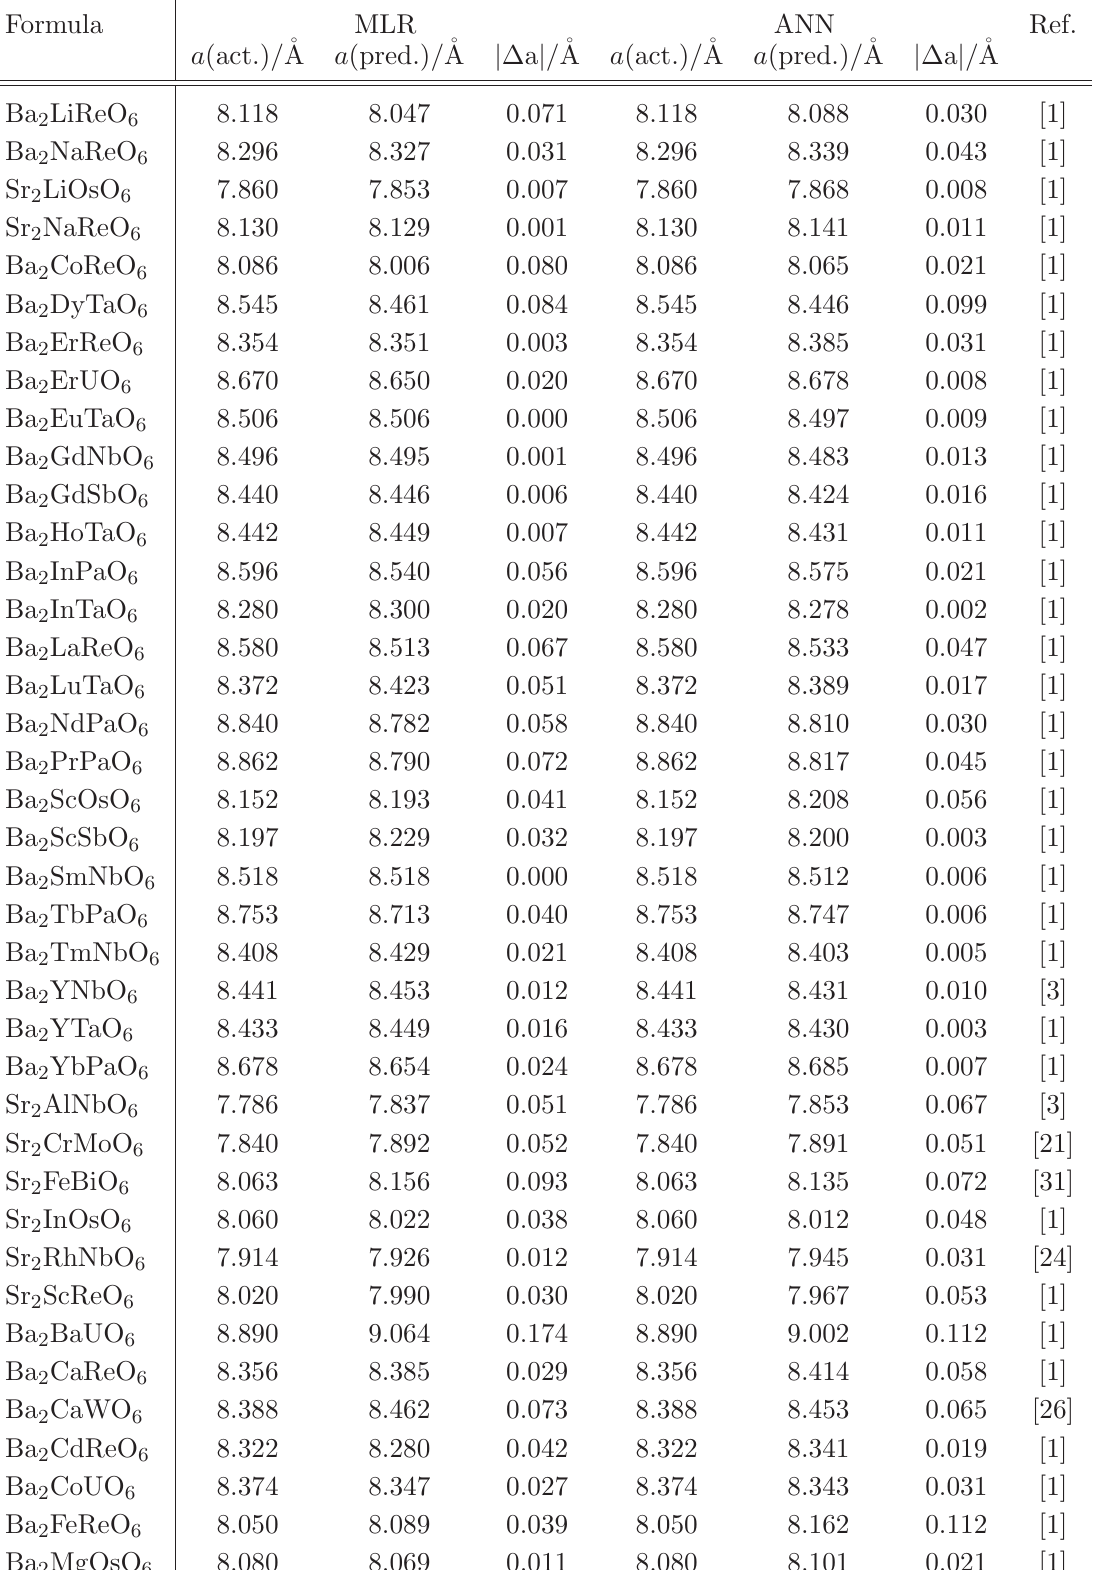
Table 4 Actual and predicted values for the unit cell edge length, as well as, absolute errors for the compounds of the test set obtained by MLR and